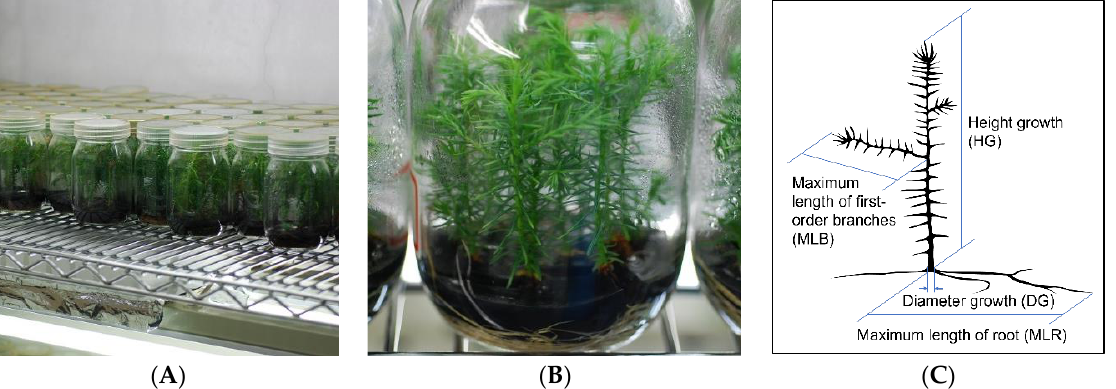
Figure 6. In vitro growth of sugi (Japanese cedar, C. japonica ) somatic plantlets. ( A ) Somatic plantlets growing in the culture room; ( B ) growth of somatic plantlets about 6 months after transfer to culture bottles; ( C ) schematic diagram of each measurement of growth trait. Bars : 5 cm.